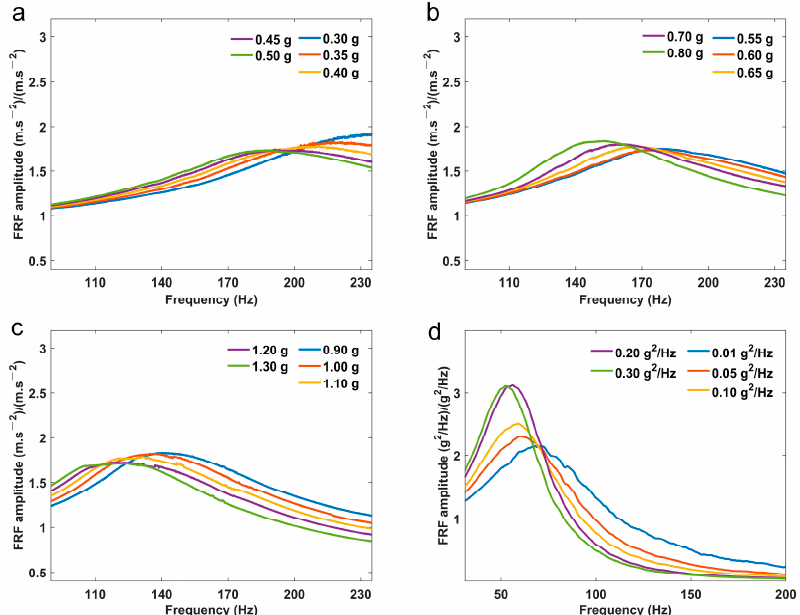
Figure 6. ( a ) FRF for [0.3; 0.35; 0.4; 0.45; 0.5] g harmonic excitations; ( b ) FRF for [0.55; 0.6; 0.65; 0.7; 0.8] g harmonic excitations; ( c ) FRF for [0.9; 1.0; 1.1; 1.2; 1.3] g harmonic excitations; ( d ) FRF for random vibrations.